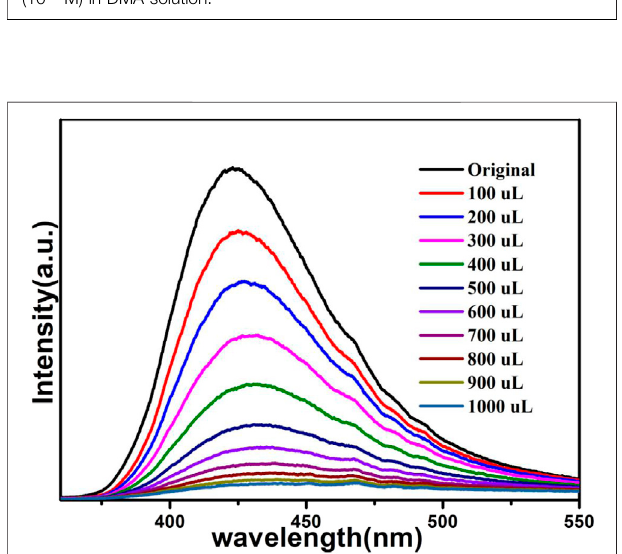
FIGURE 8 | Fluorescence of 1a in DMA containing different volumes of Fe 3+ (1 × 10 – 3 M).